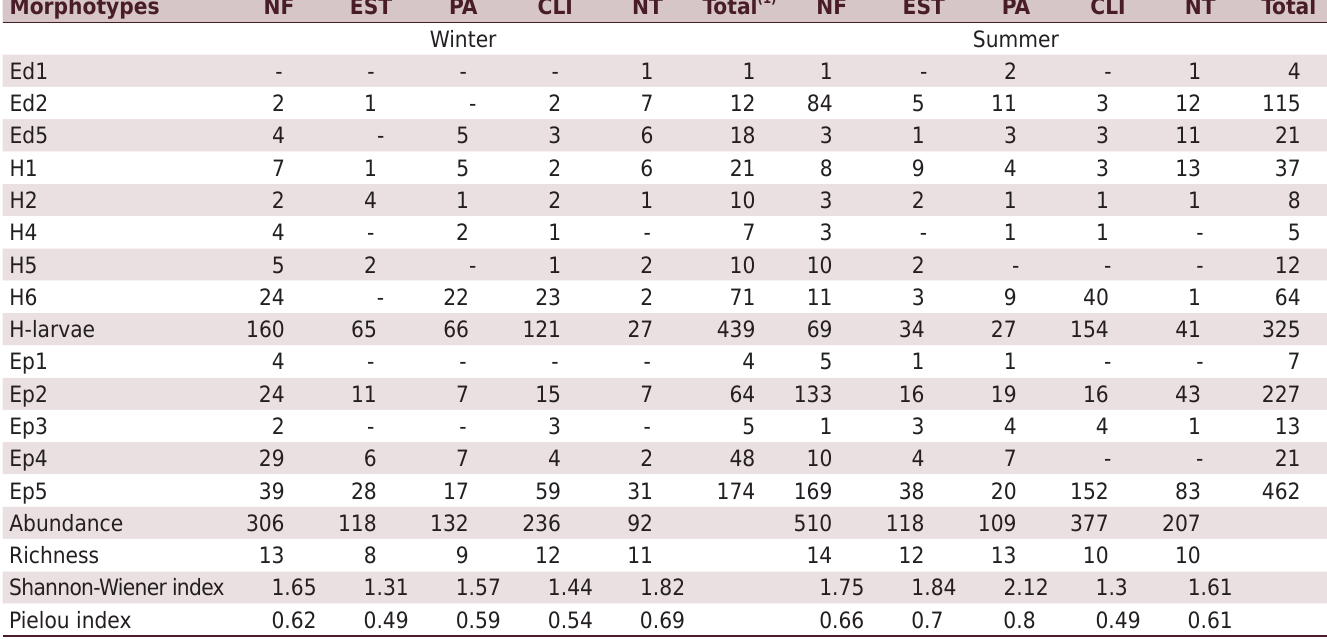
Table 5. Abundance, richness, and Shannon-Wiener diversity (H') and Pielou equability indices (J) of Coleoptera morphotypes in native forest (NF), Eucalyptus stands (EST), perennial pasture (PA), crop-livestock integration (CLI), and no-tillage (NT) systems on the Southern Santa Catarina Plateau